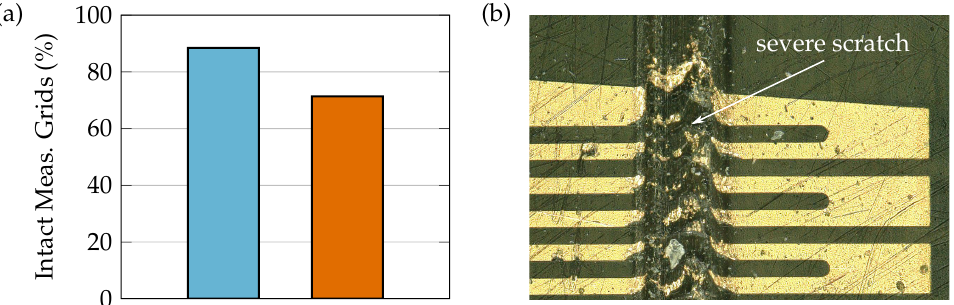
Figure 13. ( a ) Percentage of electrically intact measuring grids. About 90% of working measuring grids were obtained directly after micro fabrication on the carrier wafer (blue bar). After CFRP integration, approx. 70% of the sensor structures are intact (orange bar). ( b ) Damaged integrated sensor structure due to handling of co-cured plates on rough surface.